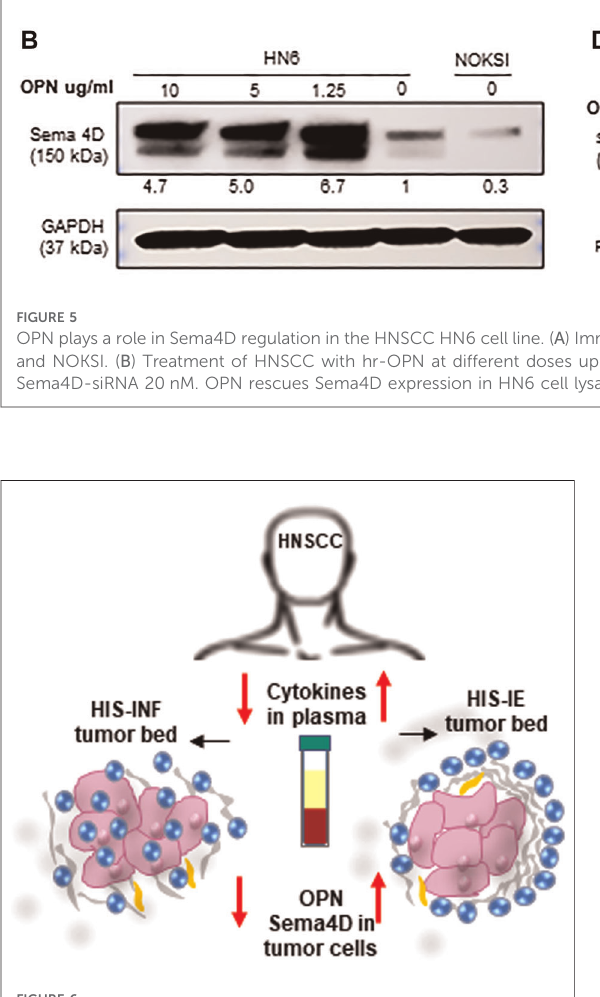
FIGURE 6 Differential cytokine expression in plasma associated with HIS subtypes of HNSCC. Low cytokine levels in plasma associate with HIS-INF while elevated cytokine levels associate with HIS-IE subtype. Sema4D and OPN-positive feedback are higher in